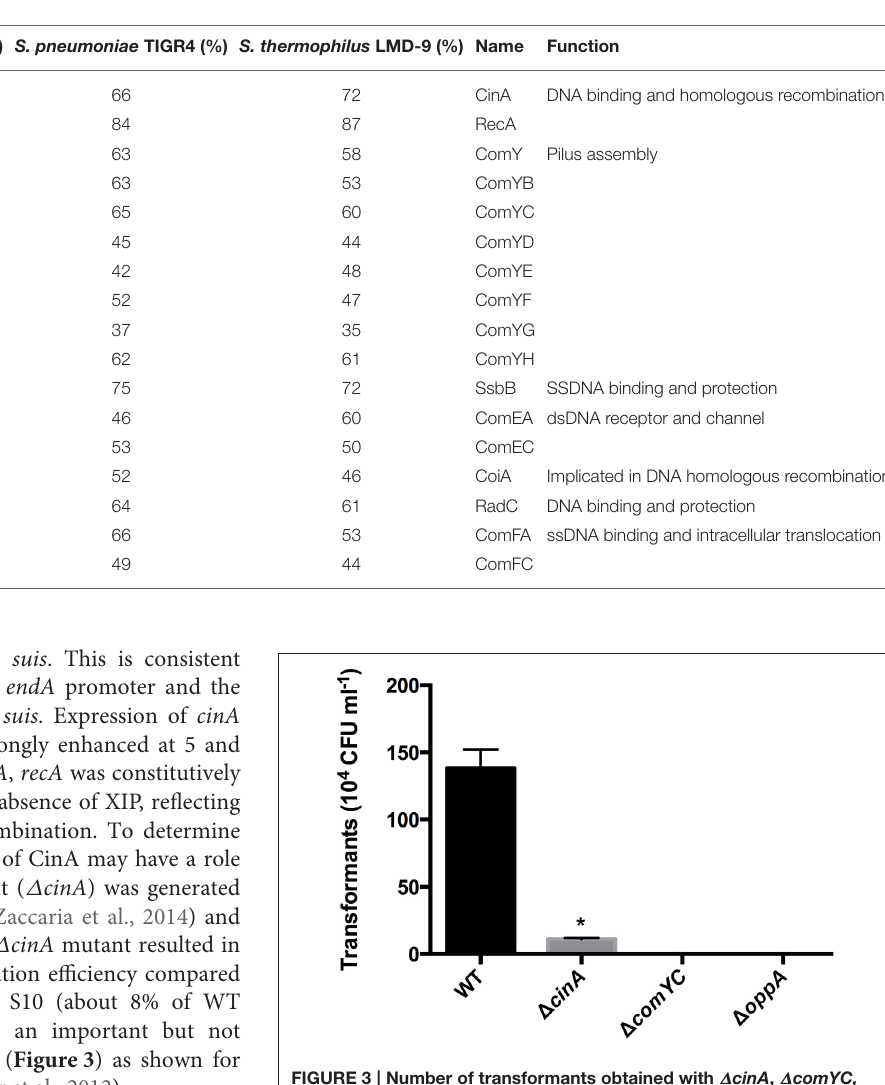
FIGURE 3 | Number of transformants obtained with ∆ cinA , ∆ comYC, and ∆ oppA deletion mutants in S. suis strain S10. The mutants described above and in Table 1 were made using Gene Splicing Overlap Extension PCR (SOE-PCR) and allelic replacement as previously described (Zaccaria et al., 2014). The efficiency of transformation was determined by plating and enumeration of chloramphenicol resistant colonies after competence induction and transformation with plasmid pNZ8084. *Indicates a significant reduction in transformation